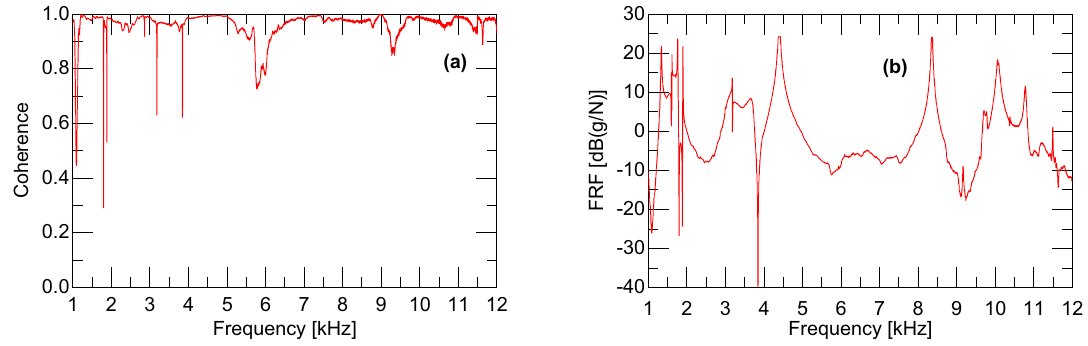
Figure 11. (a) Coherence spectrum and (b) FRF for tuning fork 15.